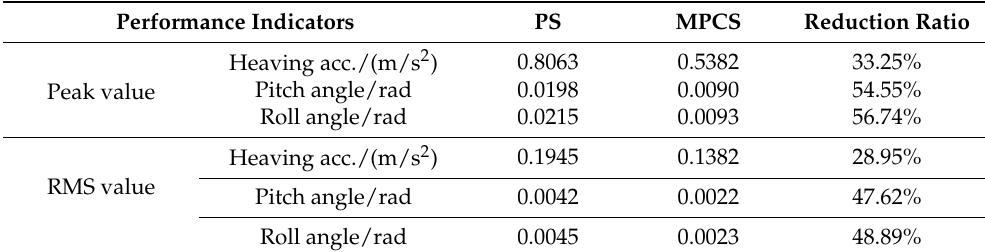
Figure 9. Simulation results of LQR attitude control for bump roads: ( a ) Heaving acceleration of car body; ( b ) Pitching angle of car body; ( c ) Rolling angle of car body. Table 3. Simulation Results of Peak Value and RMS Value of Attitude Stability Control Under Bump Road Disturbances.